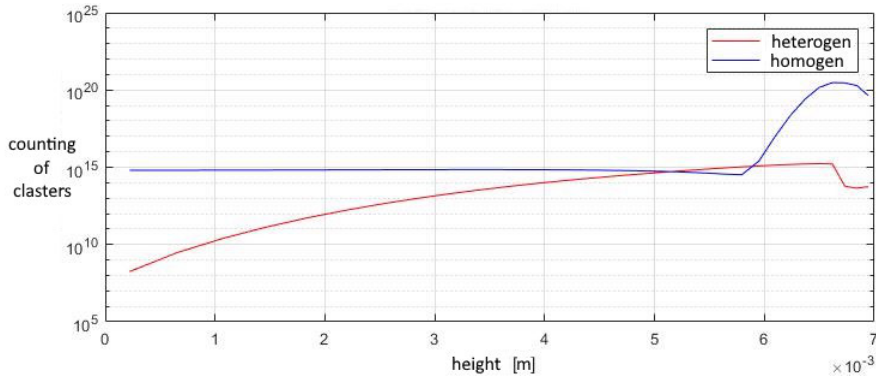
Figure 15. The number of clusters formed in the outlet section of the diffuser.